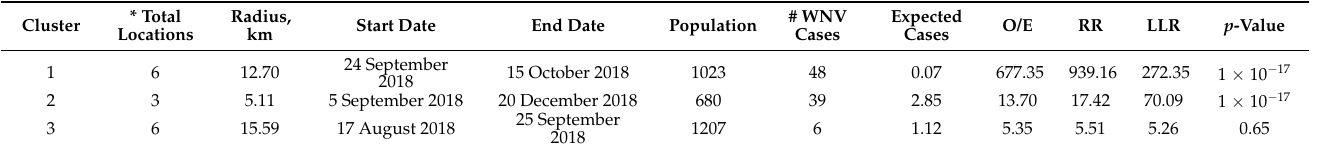
Table 3. SatScan TM spatio-temporal cluster analysis. The clusters of WNV cases detected by using spatio-temporal cluster